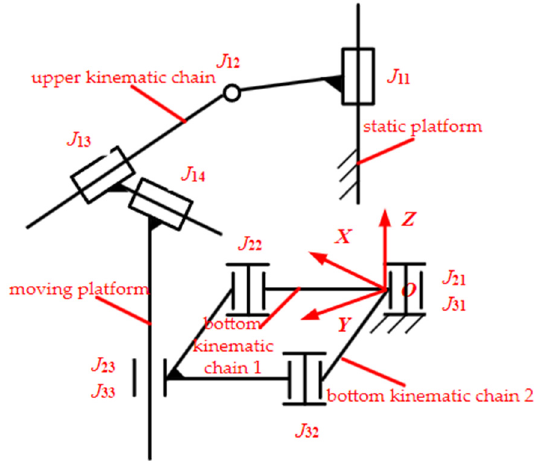
Figure 5. Kinematic sketch of robot.